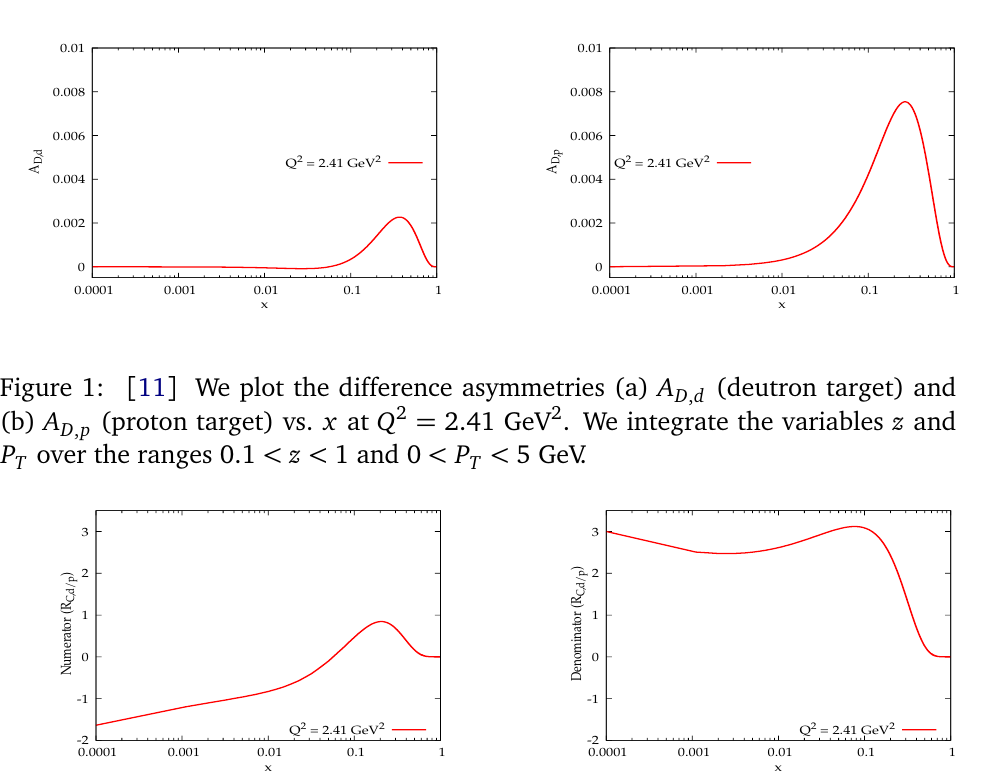
Figure 2: [ 11 ] We plot the numerator (a) and denominator (b) of R Q 2 = 2.41. We integrate the z variable over the range 0.1 < z <